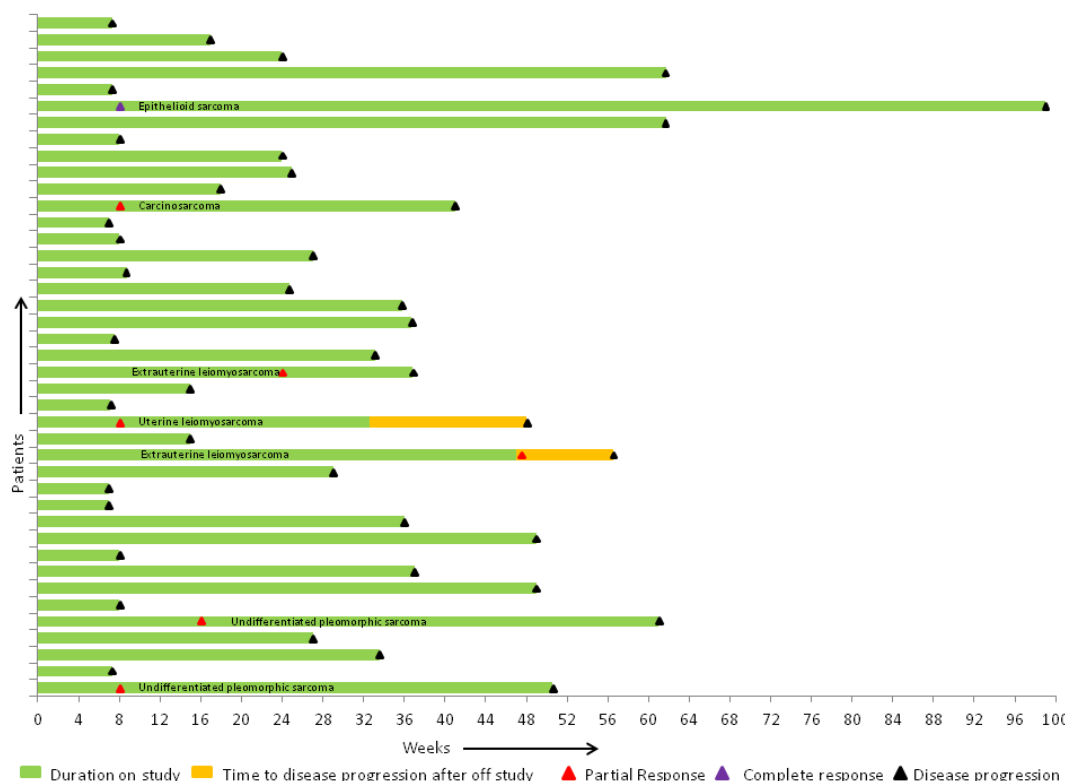
Figure 2. Summary of efficacy represented by swimmer’s plot. One complete response in epithelioid sarcoma and 6 partial responses in carcinosarcoma (1), extrauterine (1) and uterine leiomyosarcoma (2), and undifferentiated pleomorphic sarcoma (2).